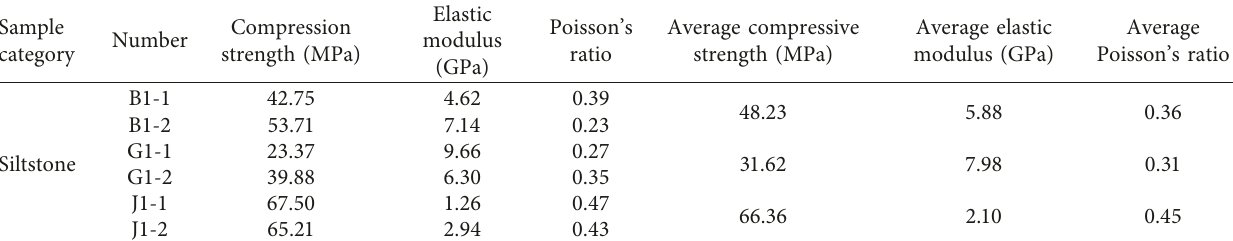
Figure 1: Chamber group layout plan. (a) Shaft station chamber and roadway layout plan. (b) Position relationship of the pump room, transport lane, and waiting room. Table 1: Test results of uniaxial compressive